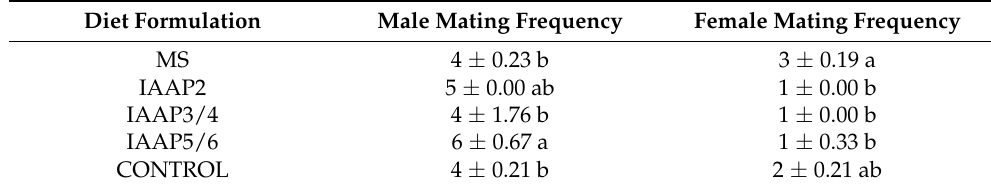
Table 7. Mean ( ± SE) mating frequency of male and female Eldana saccharina ( n = 15) from the MS, IAAP2, IAAP3/4, IAAP5/6 and control diets. Means within columns with different lower-case letters indicate significant differences ( p < 0.05). Diet Formulation Male Mating Frequency Female Mating Frequency MS 4 ± 0.23 b 3 ± 0.19 a IAAP2 5 ± 0.00 ab 1 ± 0.00 b 1 ± 0.33 b CONTROL 4 ± 0.21 b 2 ± 0.21 ab